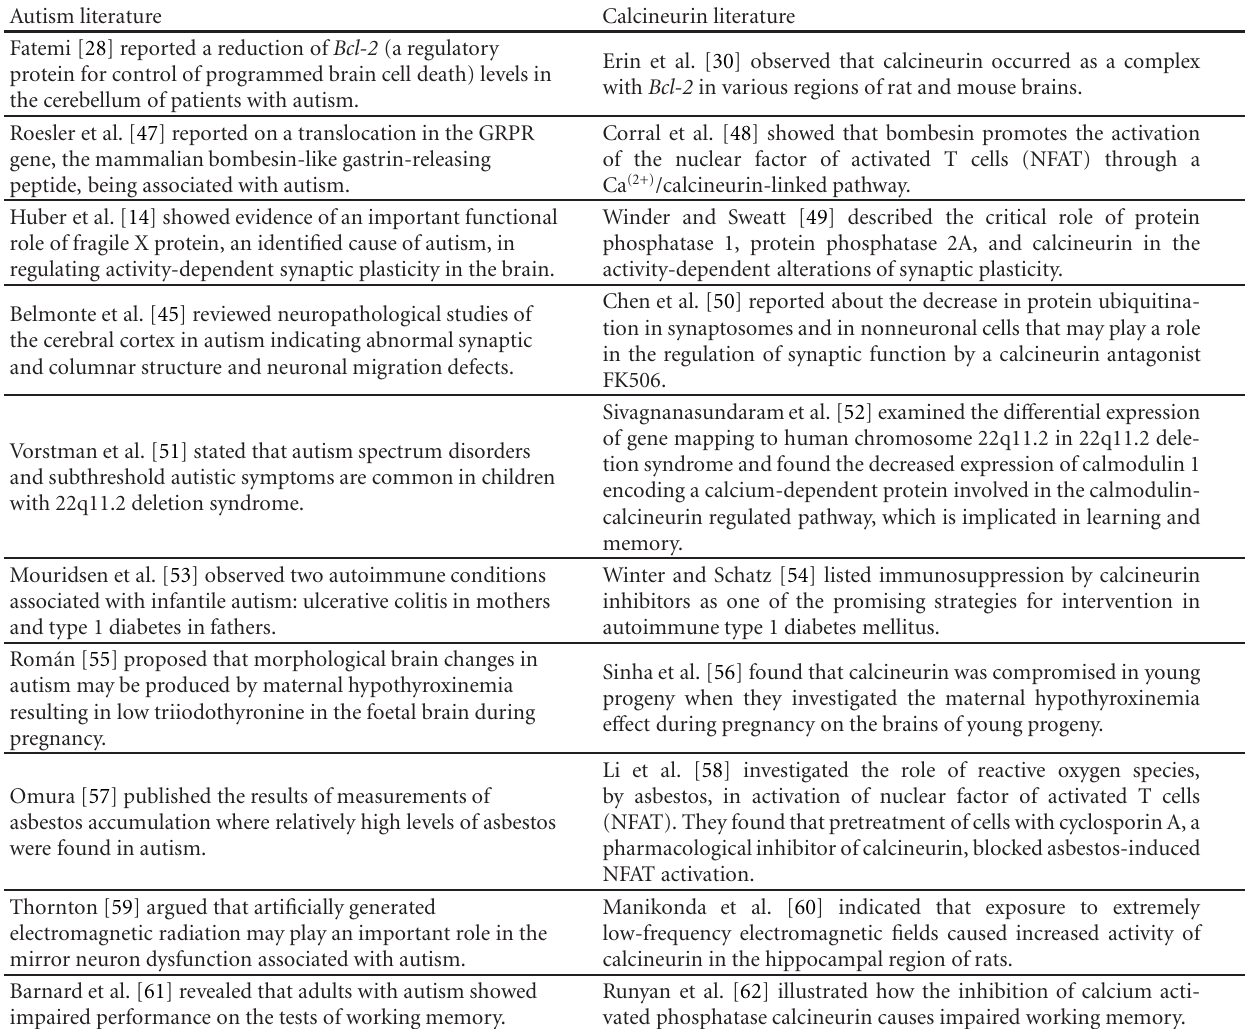
Table 1: Potential hypotheses for the relationship between autism and